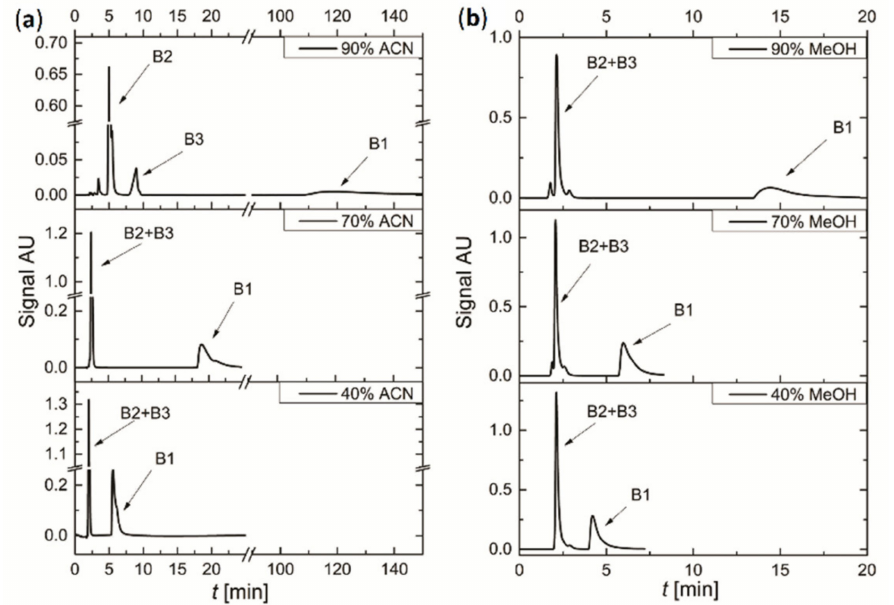
Figure 8. Preliminary results of separation of vitamin mixture obtained using column E (Eurospher II 100–5 HILIC) with: ( a ) acetonitrile–ammonia acetate buffer (10 mmol/dm 3 , pH 5) and ( b ) methanol–